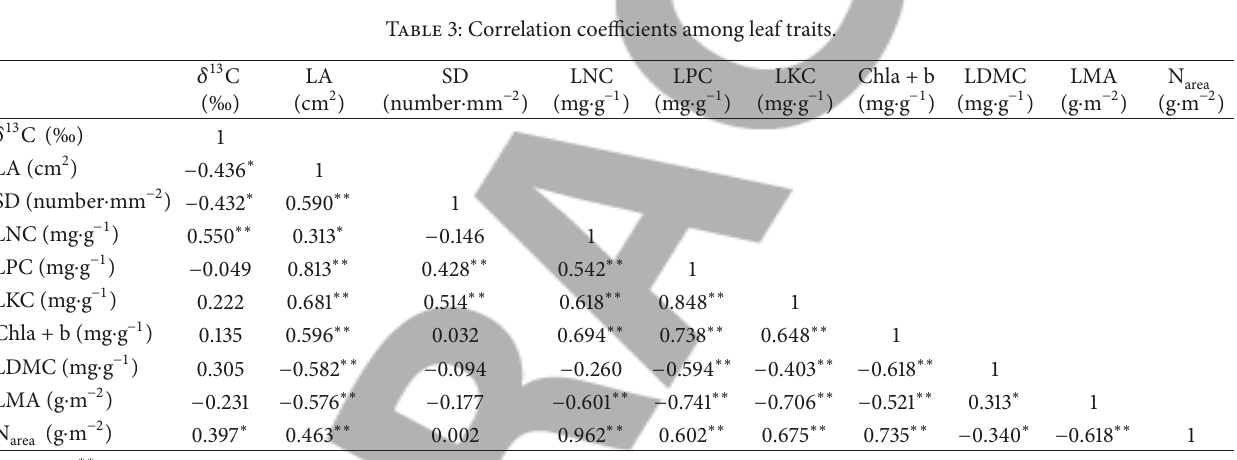
Table 3: Correlation coefficients among leaf